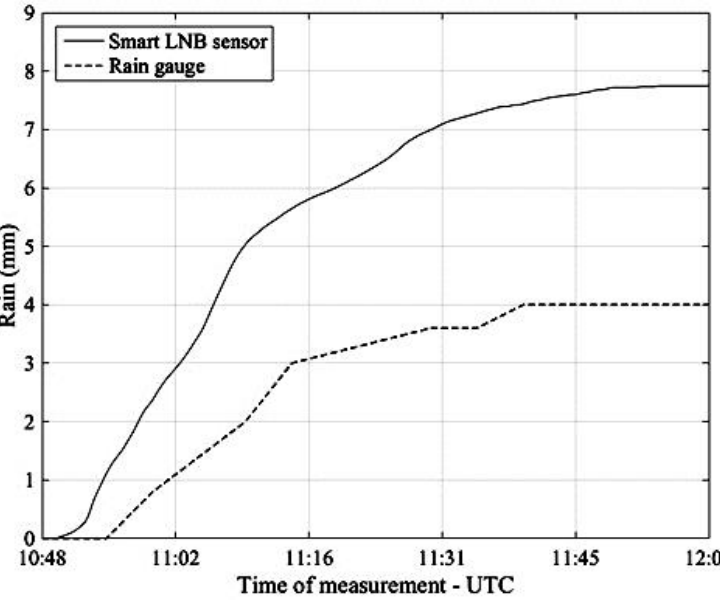
Figure 14. Pisa, 9 May 2017. Accumulated rainfall estimated by the NEFOCAST SmartLNB sensor (solid line) and measured by the TBR (dashed (solid line) and measured by the TBR (dashed line).